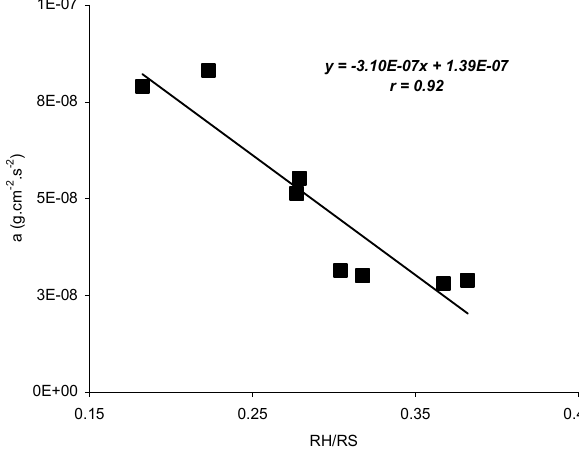
Fig. 4. Coefficient a versus RH/RS. Table 4. Values of the coefficient a for the different experimental y = 1.07x r = 0.96